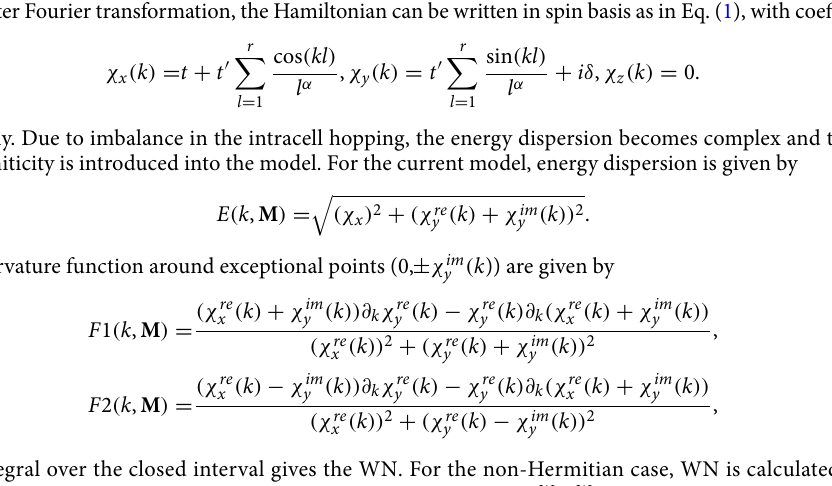
Fig. 1b. After Fourier transformation, the Hamiltonian can be written in spin basis as in Eq. (1), with coefficients,